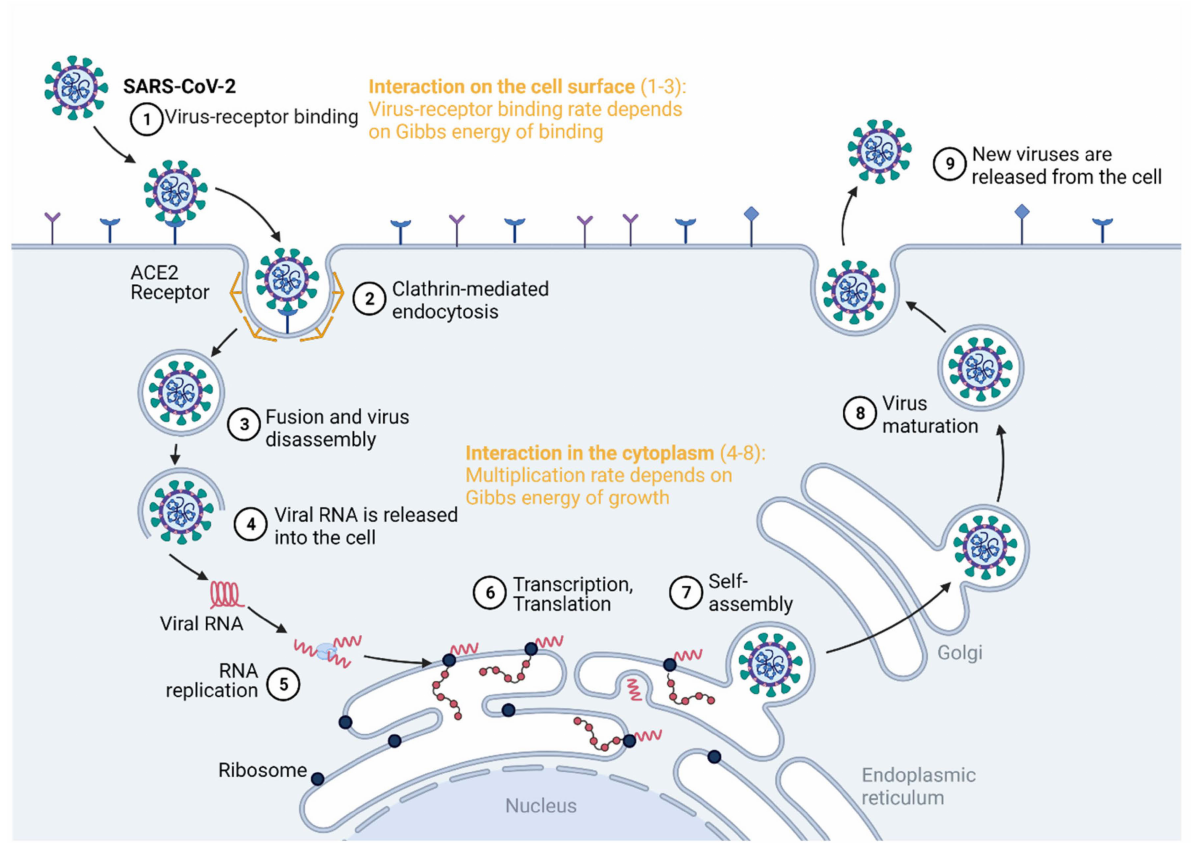
Figure 1. Virus–virus interactions can be quantified by the Gibbs energies of binding and growth. The Gibbs energy of binding quantifies the competition for cell entry, while the Gibbs energy of growth quantifies the ability to hijack the cell metabolism. Created with